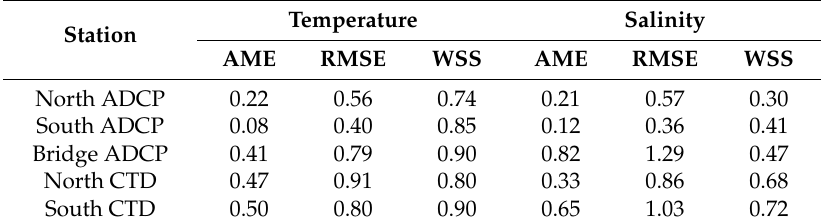
Table 3. Salish Sea model validation error statistics and skill score for temperature and salinity at different locations near Hood Canal Bridge (HCB). ADCP = acoustic Doppler current profiler; CTD = conductivity, temperature, and depth.